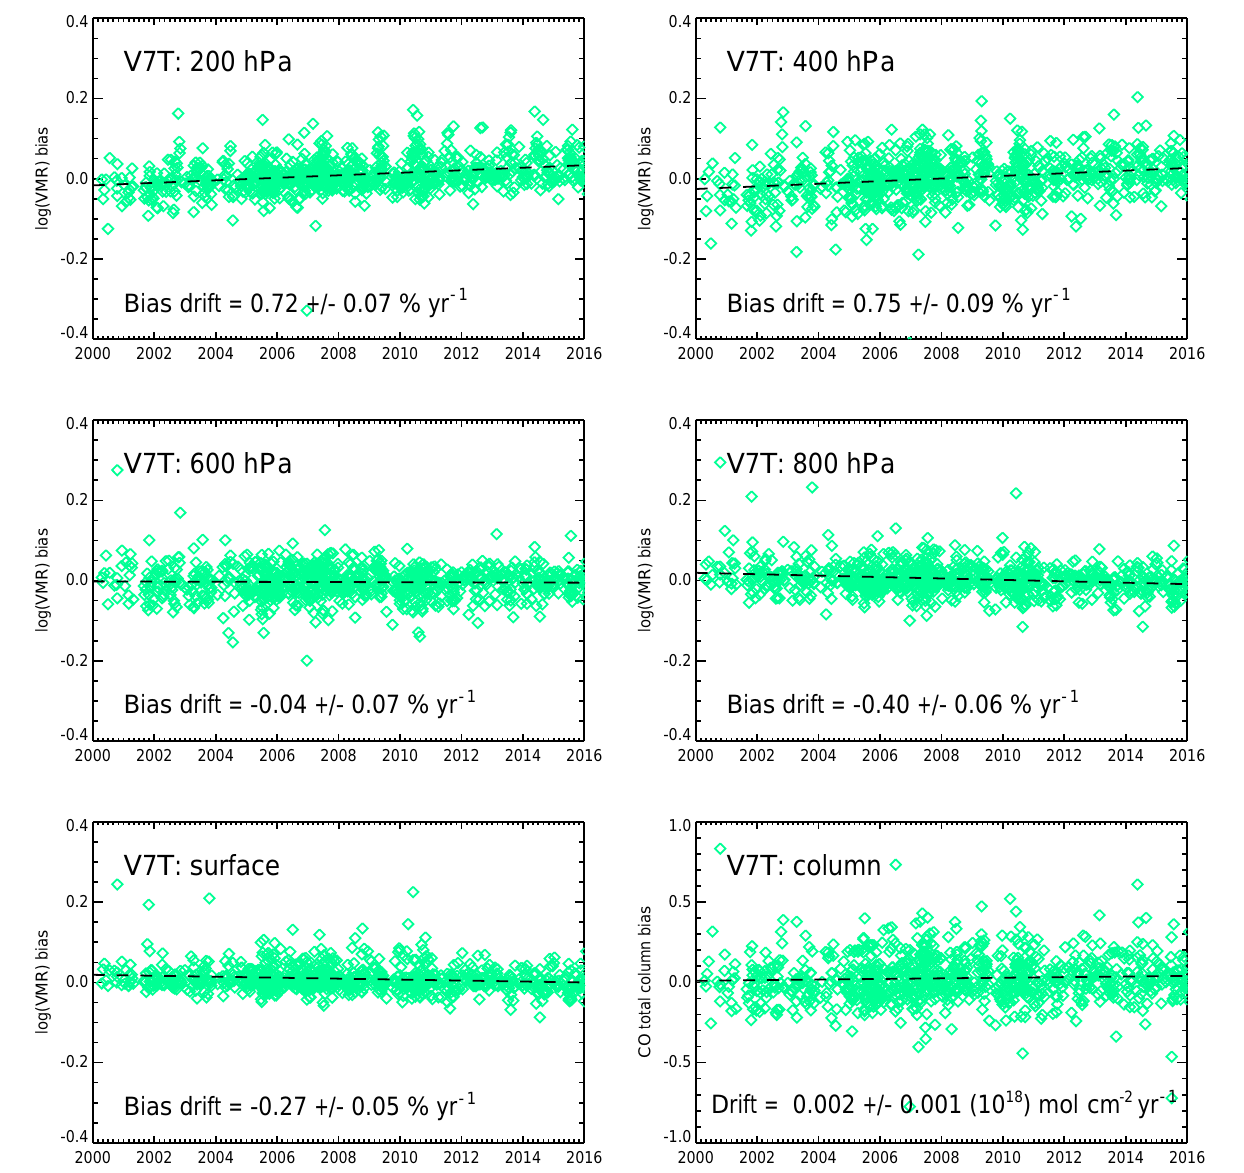
Figure 12. Retrieval bias drift for V7 TIR-only products based on the NOAA flask measurements. See caption to Fig.